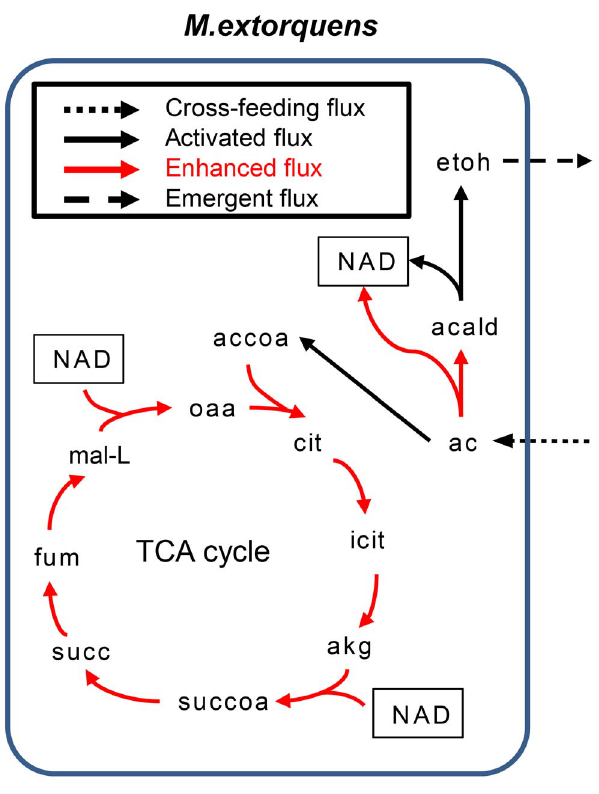
Figure 5. Metabolic reprogramming of M. extorquens that results in ethanol secretion. Major reprogrammed fluxes (compared to the mono-culture settings) are plotted. In this example, acetate that was secreted to the medium by S. oneidensis , was taken up by M. extorquens and converted into acetylCoA, leading to increased fluxes in the TCA cycle. A small portion of the acquired acetate was converted into ethanol through acetaldehyde to replenish NAD + and to facilitate energy production by the TCA cycle. Abbreviations - etoh: ethanol;